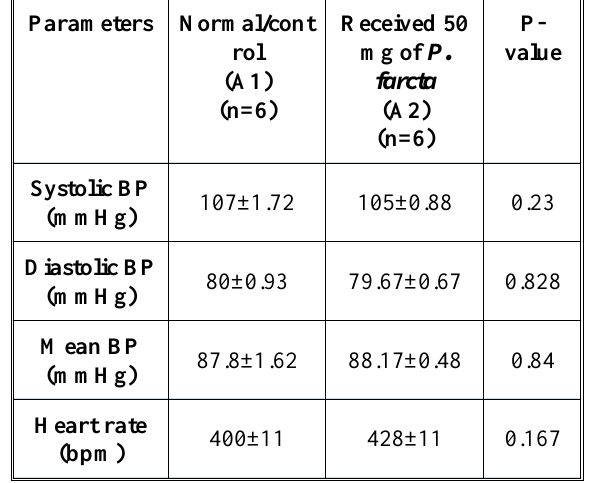
Table 1. Effects P. farcta fruit